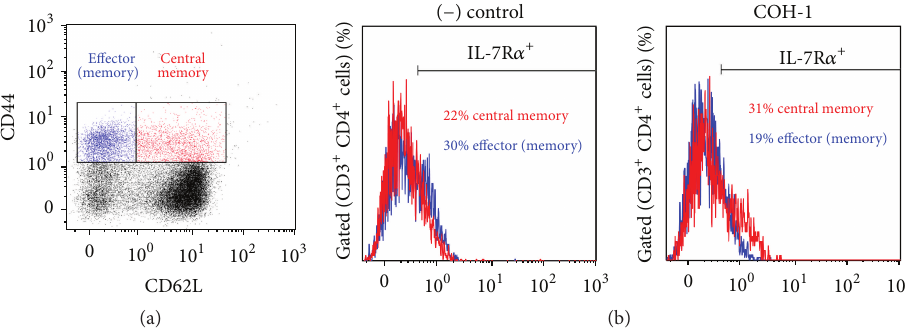
Figure 6: In vivo generation of memory CD4 + T cells during GBS infection. C57BL/6 mice were injected intraperitoneally with a dose of 10 6 CFU of wild-type GBS serotype III strain COH-1. Surviving animals who had previously displayed clinical signs were boosted with a second dose of 10 6 CFU of GBS strain COH-1 two weeks after initial infection. Spleens of animals with clinical signs and positive bacteremia were harvested 48 h after boost infection. Total splenocytes were stained and analyzed by multiparametric FACS. (a) Cells were gated on CD3 + CD4 + double-positive cells, followed by gating CD 44 high CD62L − (effector [memory] T cells) and CD 44 high CD62L + (central memory T cells). A histogram from a representative control (mock-infected) mouse was selected for the figure. (b) A fifth surface marker, IL-7R 𝛼 + , was used to further identify memory cells (CD 44 high IL-7R 𝛼 + ) within the CD 44 high CD62L − (effector [memory] T cells) and CD 44 high CD62L + (central memory T cells). IL-7R 𝛼 + cells reflect memory cells within these respective populations. Histograms from representative control (mock-infected) and infected mice were selected for the figure. Thirty thousand events gated on CD3 + CD4 + cells were acquired per sample and data analysis was performed using Kaluza® Flow Analysis software.